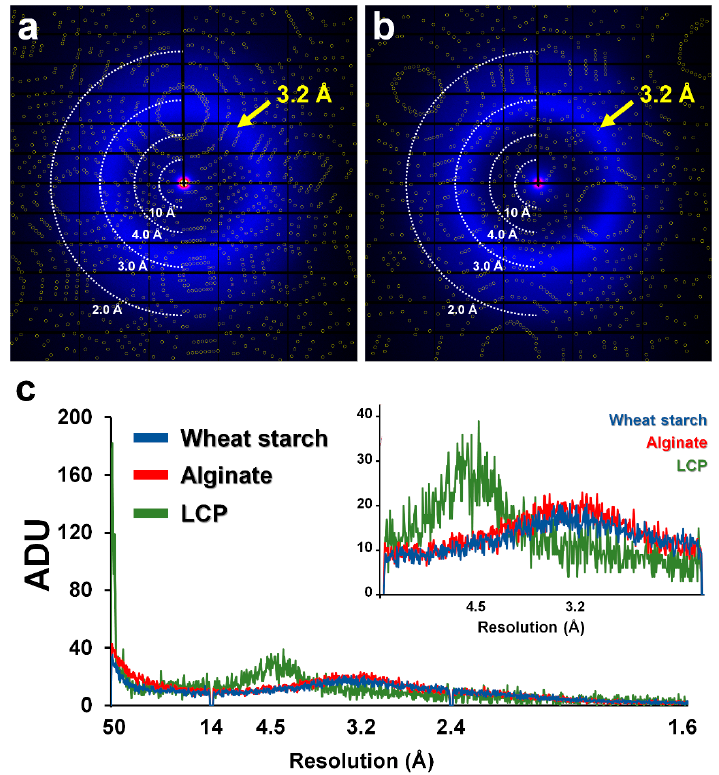
Figure 3. Measurement of X-ray background scattering of WS and alginate. Diffraction pattern of glucose isomerase embedded in 10% ( w / v ) ( a ) WS and ( b ) alginate delivery media. The circles show predicted positions of Bragg peaks by CrystFEL. ( c ) 2D profile of the average scattering of WS (blue), alginate (red), and LCP (green). (Inset) Magnified view of background scattering in the range 14–2.4 Å. Yellow arrows indicate 3.2 Å resolution area .